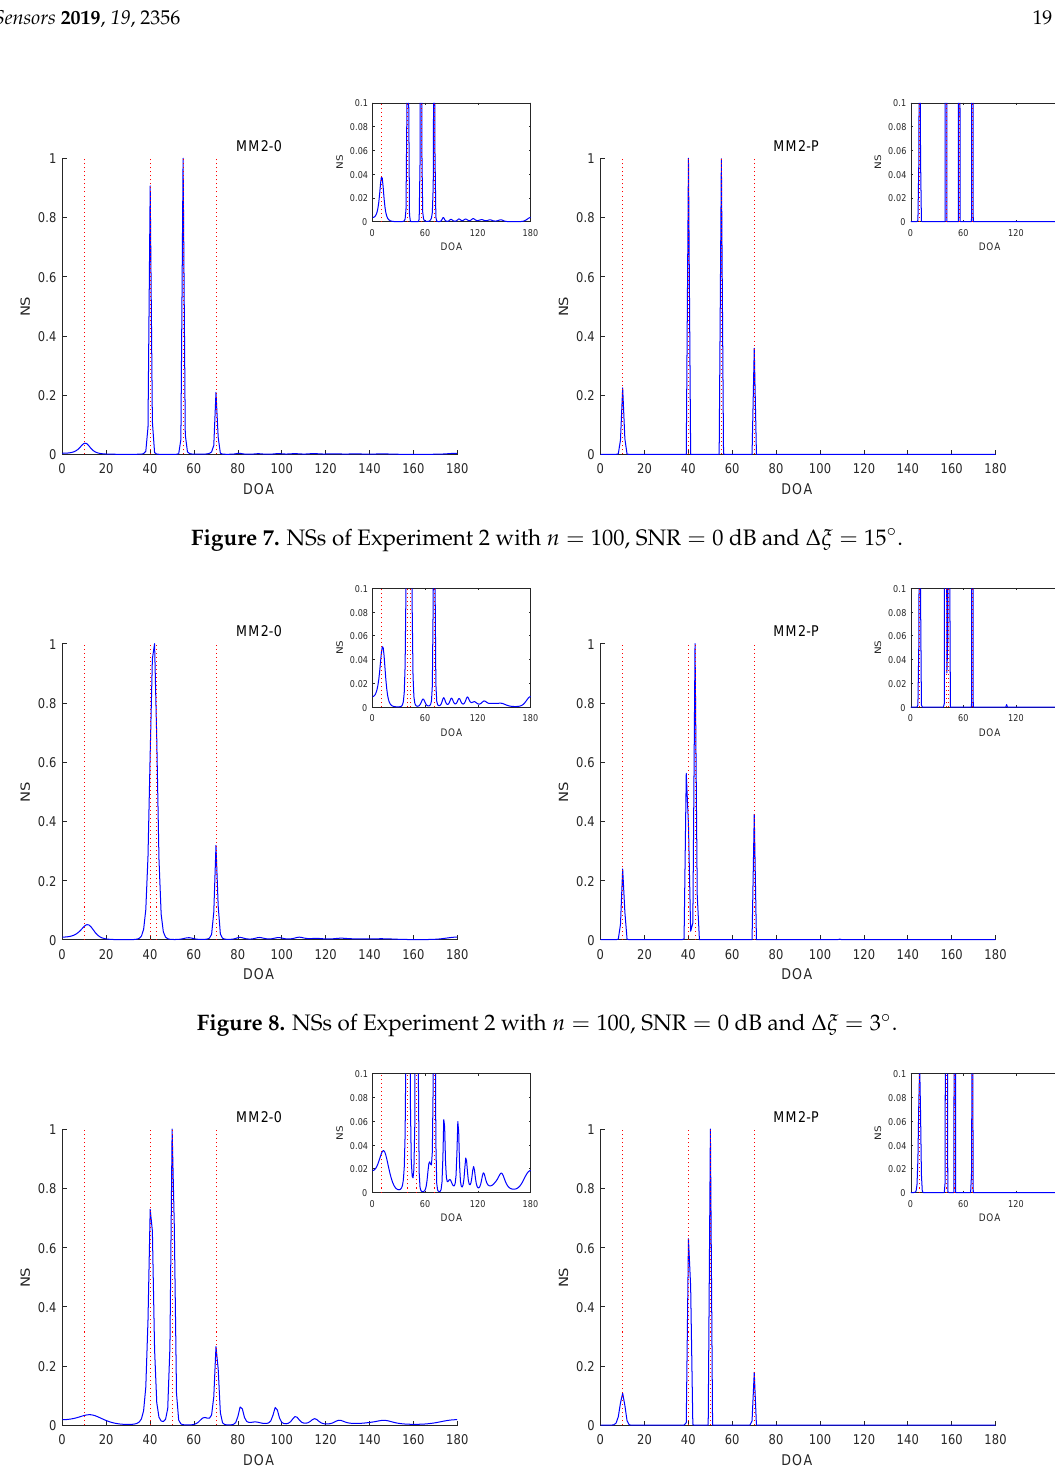
Figure 9. NSs of Experiment 2 with n = 20, SNR = − 10 dB and ∆ ξ = 10 ◦